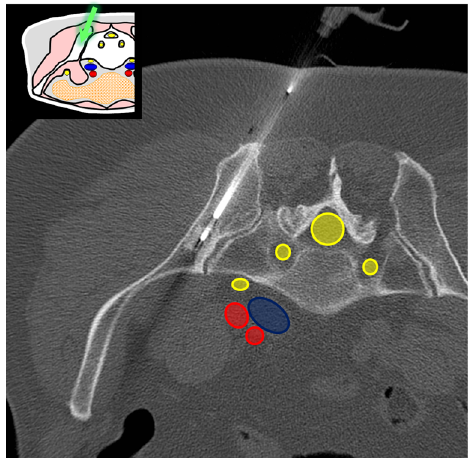
Fig. 5 A 72-year-old man with clinical background of prostate cancer presenting with a new blastic lesion in the iliac bone. A posterior approach through the posterior iliac tuberosity was used to perform a biopsy with an 11-G bone biopsy needle confirming prostate metastasis. The choice of a needle path along the greater axis of the iliac bone allows taking multiple samples